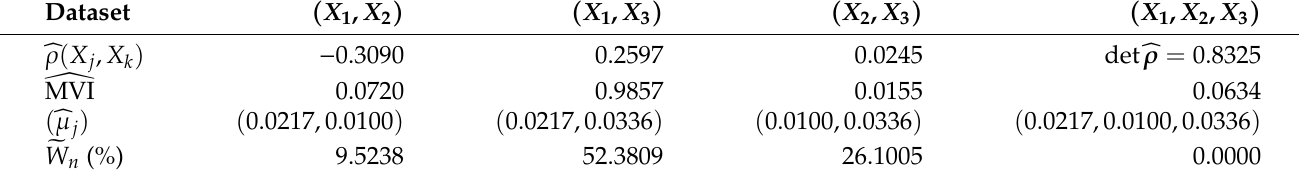
Table 5. Correlations, MVI, parameter estimates and diagnostic percents of bi- and trivariate cases.